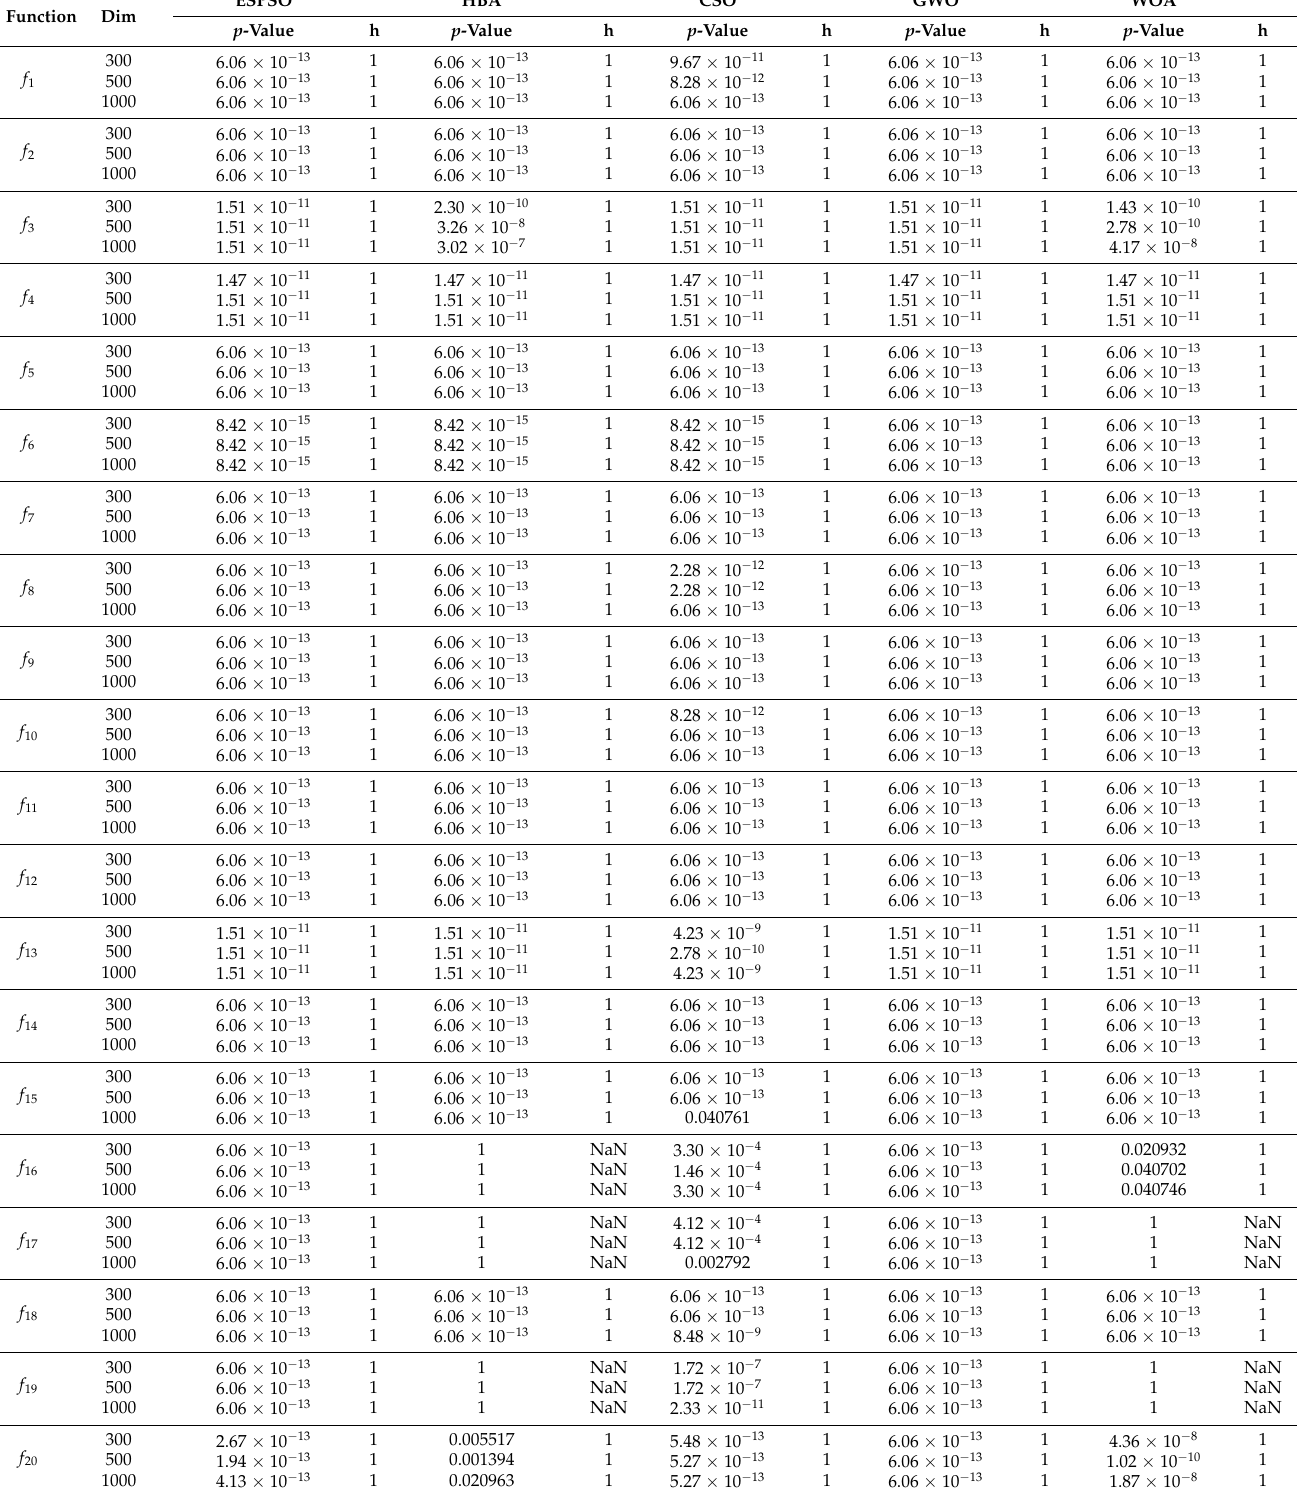
Table 6. Comparison results of Wilcoxon rand test sum for all test